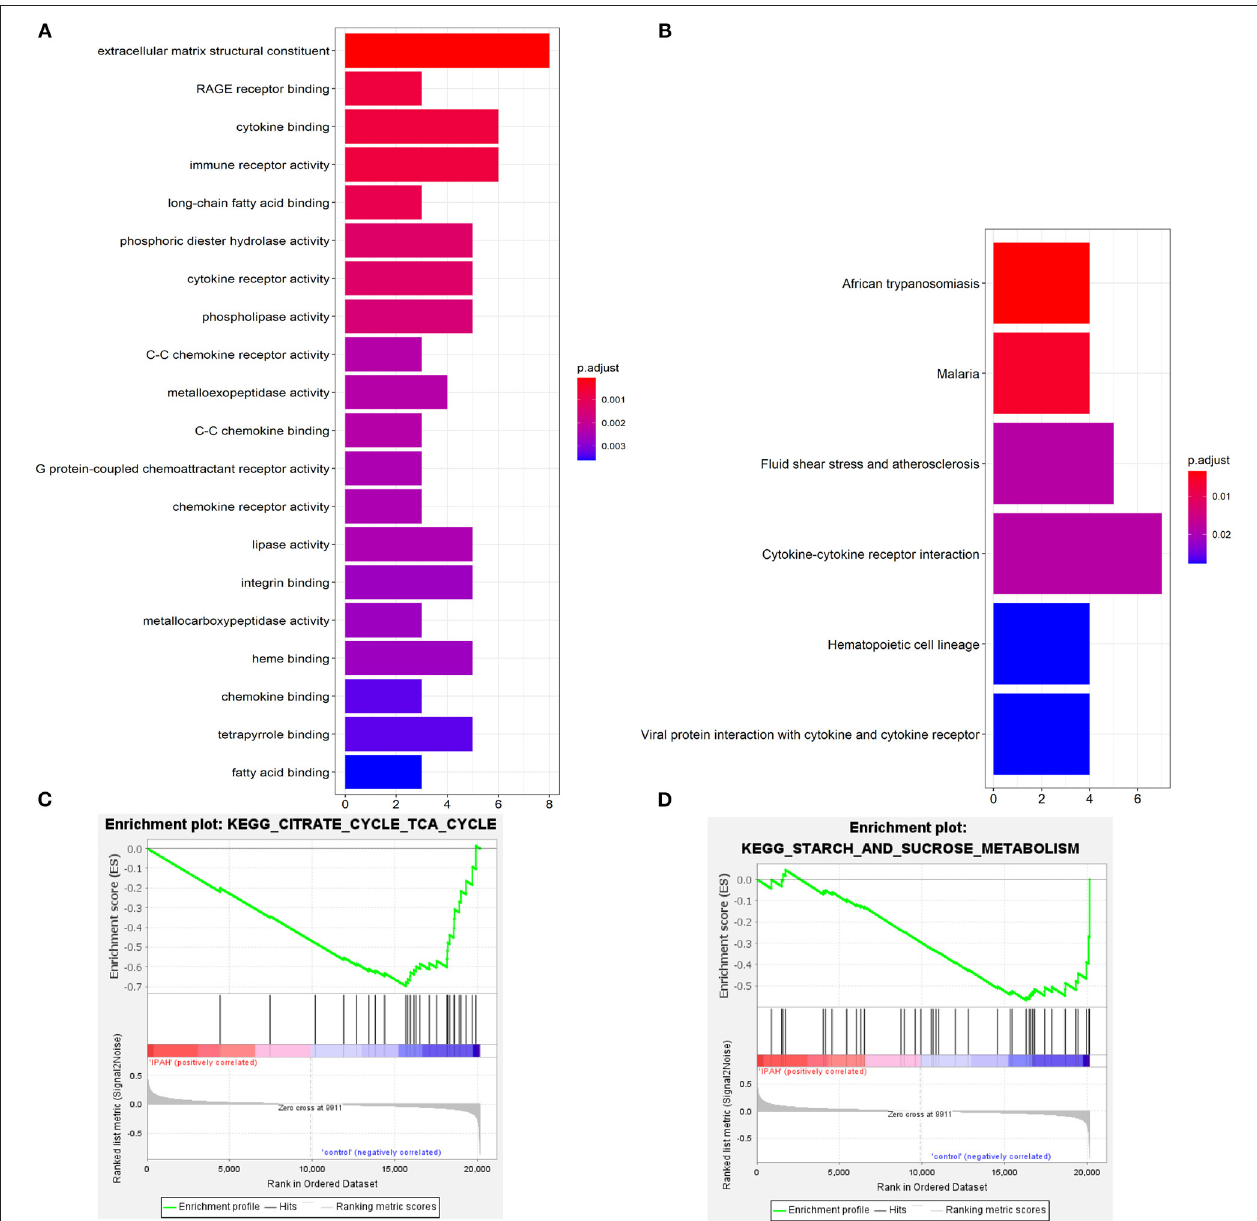
FIGURE 3 | The functional enrichment analysis of DEGs. (A) The GO enrichment; (B) The KEGG enrichment; (C,D) The GSEA enrichmen analysis.